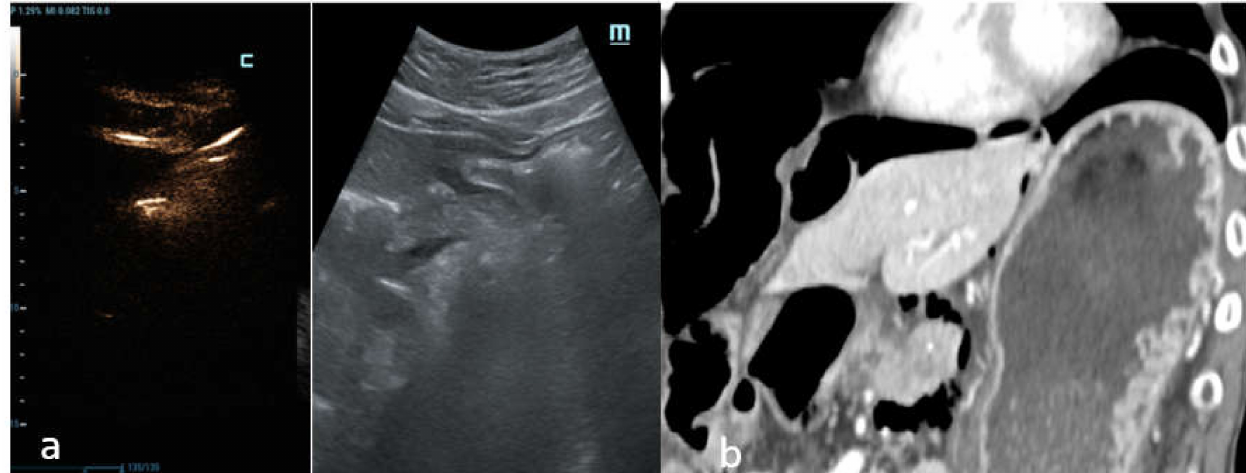
Figure 4. Male patient, 71 years old with story of analgesic abuse for myalgia in treatment. ( a ) Lon- gitudinal US scan on the hepatic falciform ligament; the C-mode and B-mode image windows are displayed side by side. The C-mode shows the intensely bright appearance of a small amount of air placed along the falciform ligament; this discovery is explicit on C-mode and more evident than B-mode. ( b ) Coronal MPR reconstruction of abdominal CT in venous phase of the same patient demonstrates the presence of pneumoperitoneum with free air bubbles around the liver and the falci- form ligament. Perforation in the first tract of duodenum was identified via laparotomy performed in the emergency